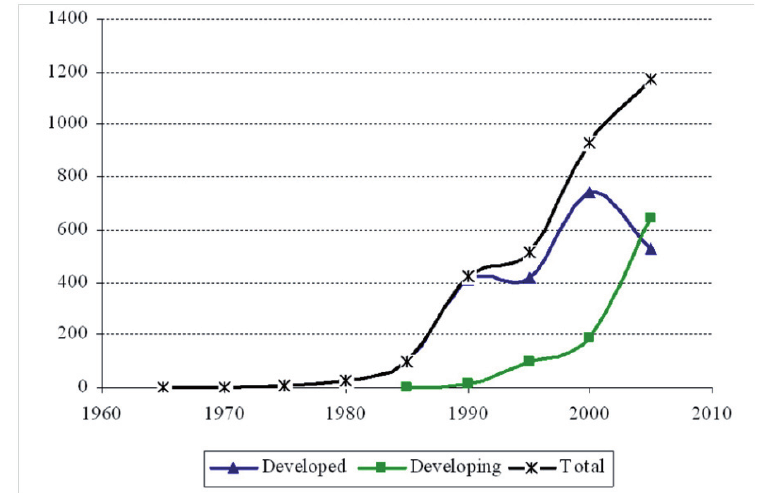
Fig. 1 – Growth comparisons in business Incubators. Source: Akcomak